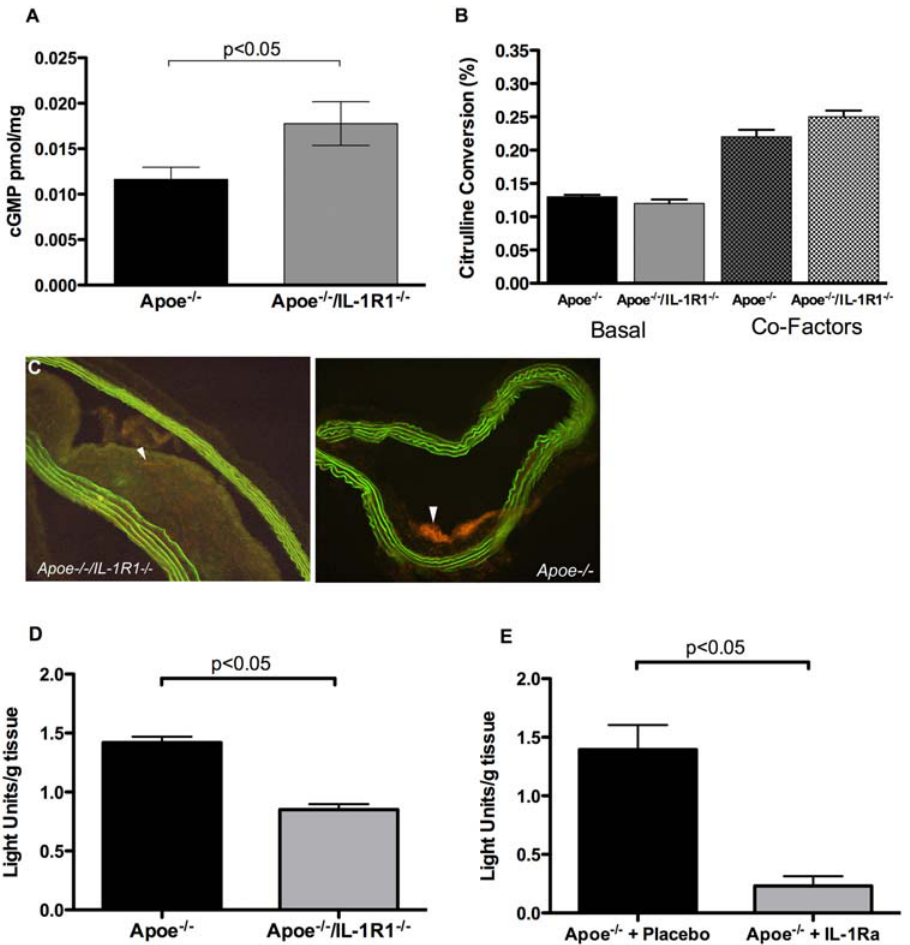
Figure 4. NO activity, ROS and NOS expression in mice fed WHC diet. (a) cGMP in lung homogenates (n=14), (b) eNOS enzymatic activity (n=6) and (c) in-situ ROS (white arrowhead) in Apoe 2 / 2 /IL-R1 2 / 2 and Apoe 2 / 2 mice fed WHC. (Note: images chosen illustrate ROS levels not atherosclerotic lesion size) . Chemiluminescent quantification of ROS in mice fed WHC (d) and Apoe 2 / 2 mice fed WHC diet (n=9) and administered hrIL-1ra (n=4) (e)